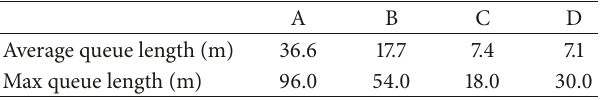
Table 1: O/D matrix for Marconi Roundabout. Table 2: Queue lengths measured for each entry of Marconi Round- about.